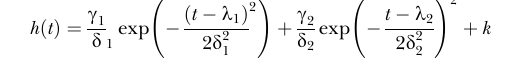
Figure S5. Fits to the Time Course Data I: Experiment 1